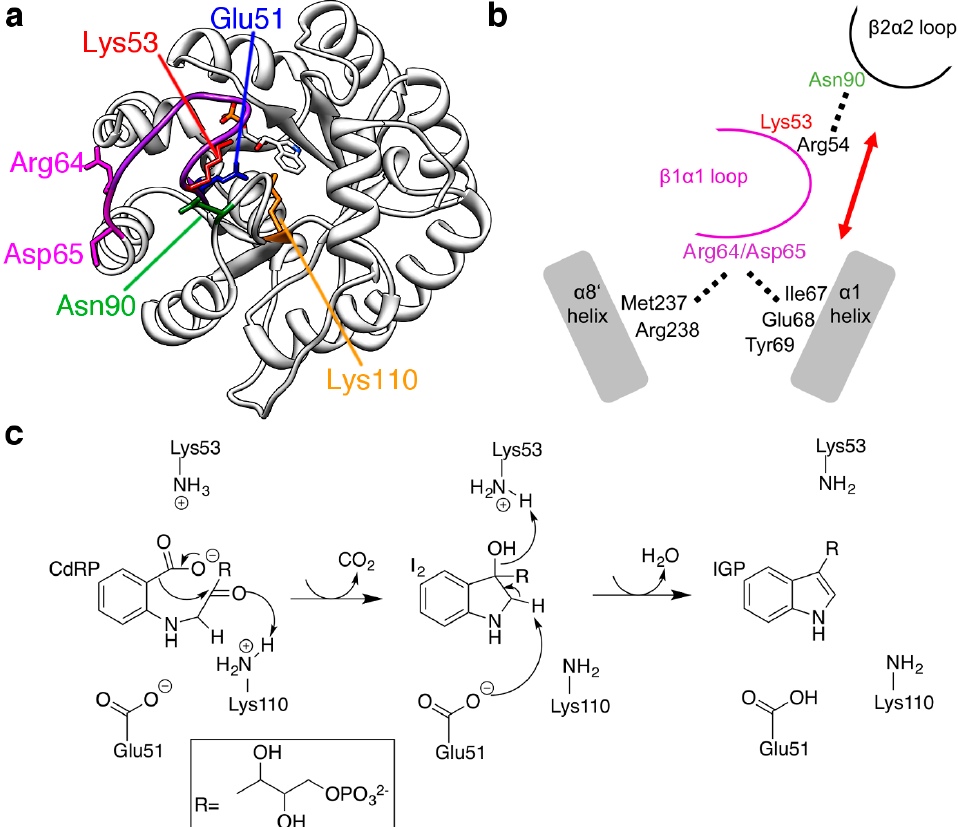
Figure 1. Competing β 1 α 1 loop interactions are important for ssIGPS function. ( a ) Structure of the ssIGPS enzyme (PDB 1A53 [28]), showing the β 1 α 1 loop in purple, catalytic residues Glu51 (blue), Lys53 (red) and Lys110 (orange), and residues modified in this manuscript to change the structure/dynamics of the β 1 α 1 loop, including Arg64, Asp65 (both magenta) and Asn90 (green); ( b ) schematic highlighting the hydrogen bonding interactions of the β 1 α 1 loop. On the C -terminal side of the loop, Arg64 and Asp65 engage in a hydrogen bonding network including residues on the α 1 and α 8’ helices. On the N -terminal side, Asn90 from the β 2 α 2 loop can hydrogen bond with residues on the β 1 α 1 loop, including Arg54. We propose that the β 1 α 1 loop fluctuates between conformations favoring interactions on each side of the loop; ( c ) chemical mechanism of ssIGPS [25]. Lys110 initiates ring closure and decarboxylation by protonating the carbonyl oxygen. Glu51 and Lys53 act as the general base and acid, respectively, in the dehydration step. Importantly, Lys53 is on the β 1 α 1 loop and Glu51 is on the β 1 strand preceding the loop. Changes to the structural dynamics of the β 1 α 1 loop would likely affect the chemical environments and positioning of these